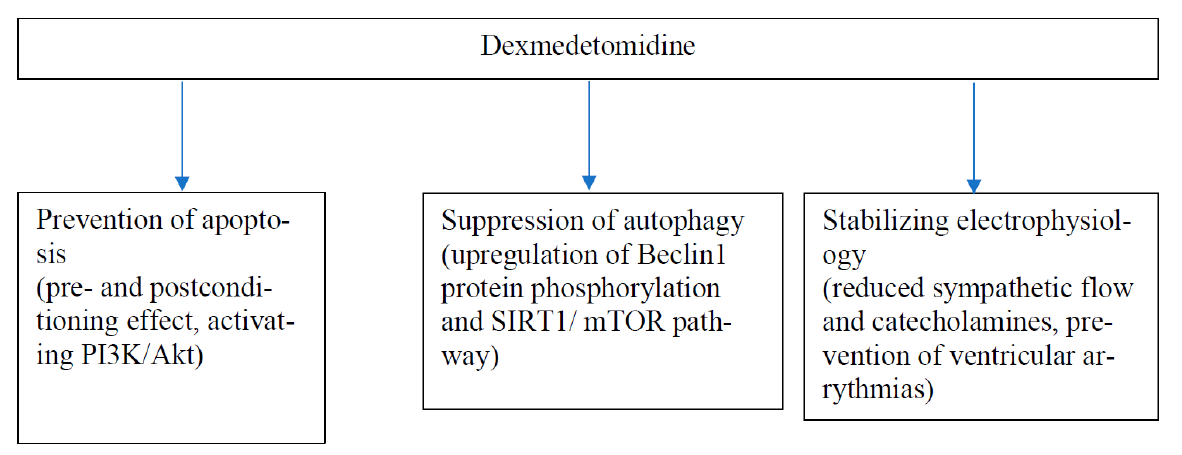
Figure 1. A model for main mechanisms (with two examples) of cardiac protection of DEX.